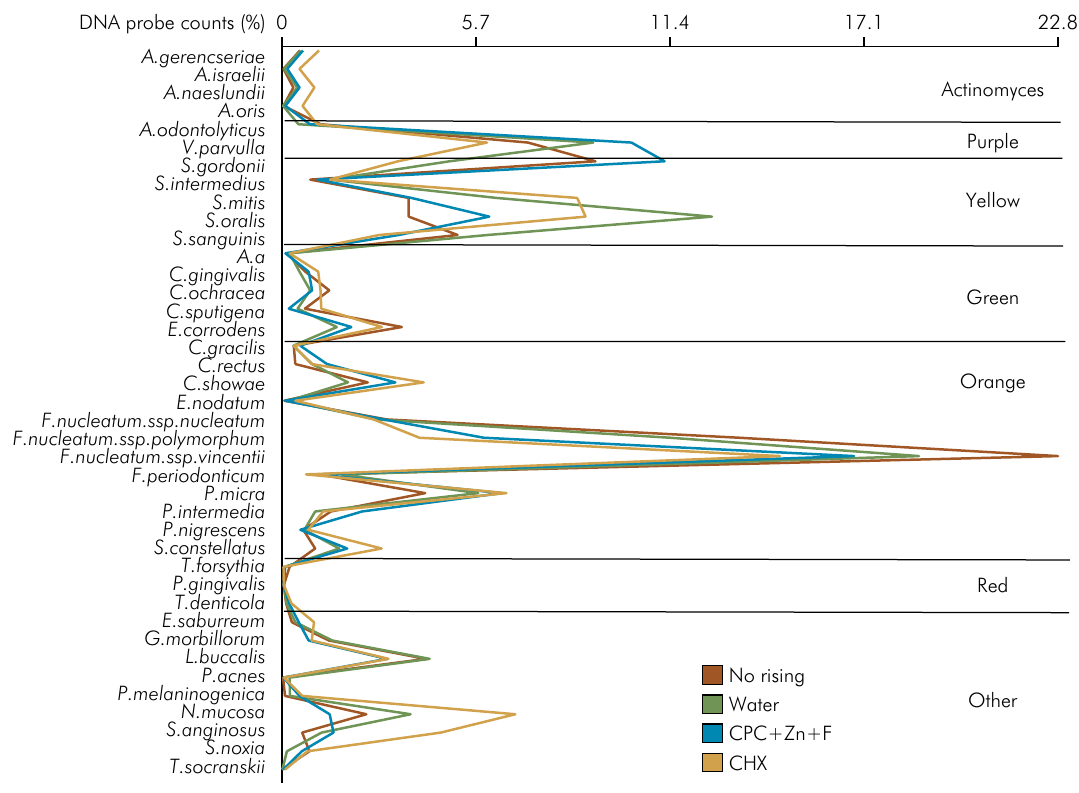
Figure 4. Mean percentage of DNA probes counts of 40 subgingival species in the four experimental groups. The species were ordered according to the microbial complexes described by Socransky et al. 30 The proportion that each species was determined for each participant and then averaged in each experimental group. The significance of differences among the four groups was assessed using Kruskal-Wallis test (p < 0.05, adjusted for multiple comparisons).